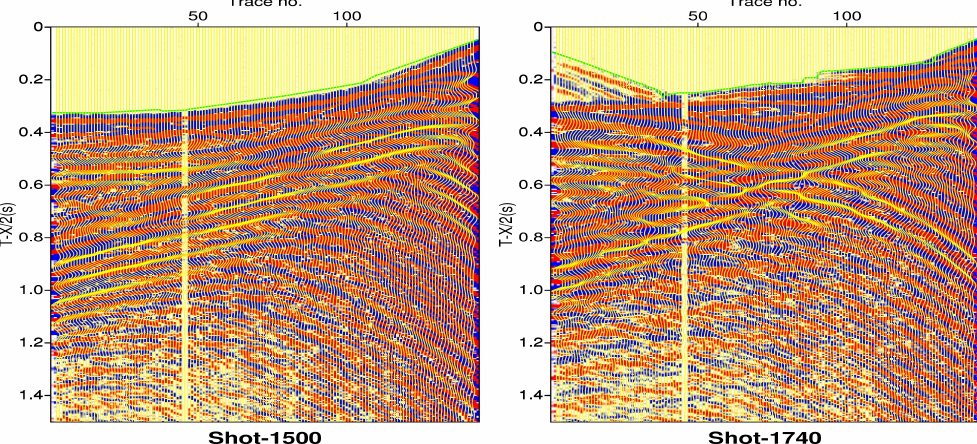
Figure 8. Raw data (blue-red color) and synthetic data (yellow wiggle) for shot 1500 and 1740 showing the match of first arrivals within half a wavelength. Synthetic data are calculated using the final traveltime inversion velocity model. Travel time picks (green line) are plotted for comparision.